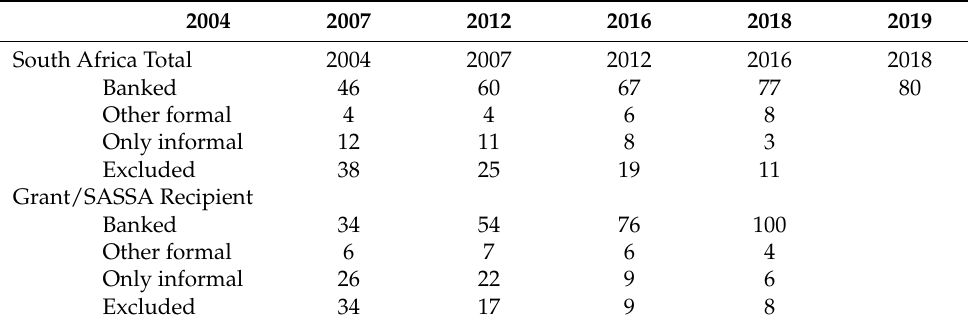
Figure 1. Financial inclusion 2007–2018 Source of data: (FinMark Trust 2019). Table 1. Inclusion of Grant recipients.